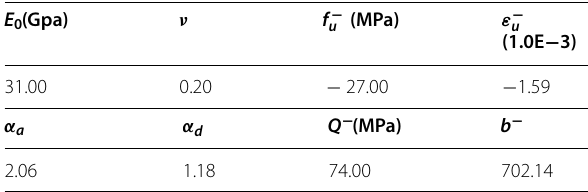
Table 1 Material constants identified from the experimental results (Karsan and Jirsa 1969).